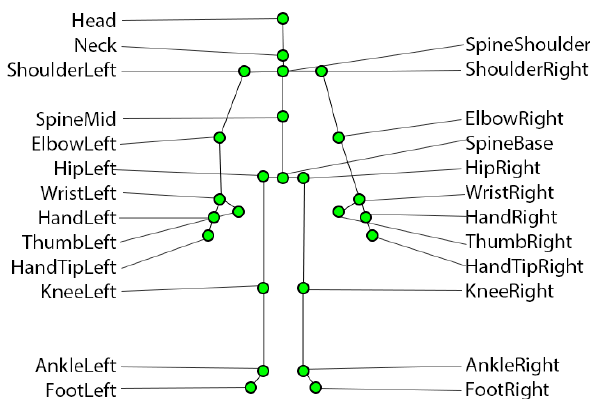
Figure 1. This figure shows the 25 positions captured by the